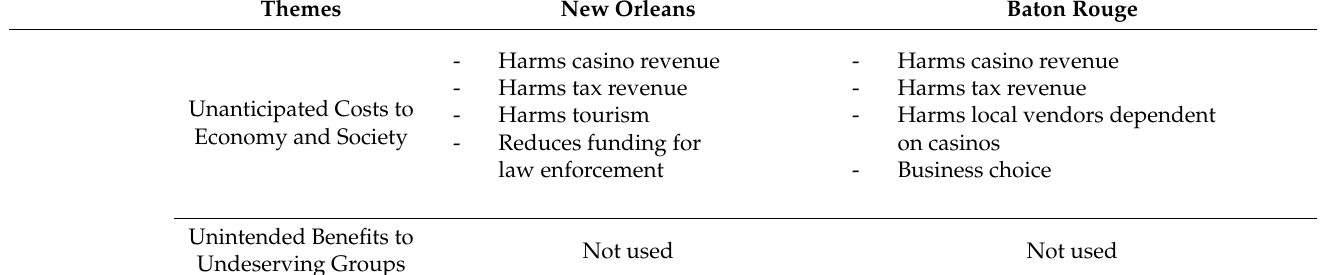
Table 3. Comparison of the Policy Dystopia Model and use of its Tobacco Industry Discursive and Instrumental Strategies by the Gaming Industry in Major Louisiana Policy Battles